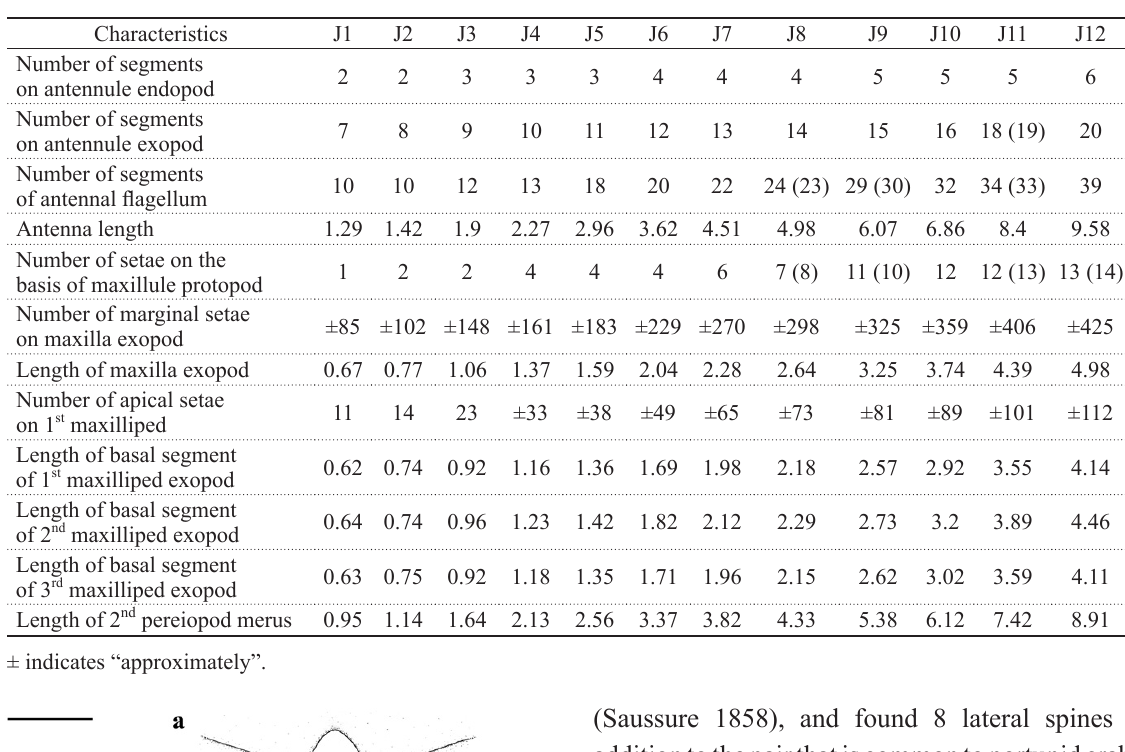
Callinectes danae Smith, 1869. The main morphological characteristics for the identification of the first 12 stages of the juvenile phase. The dimensions were taken in millimeters and represent mean values. Numbers in parenthesis mean alternative values with low occurrences.